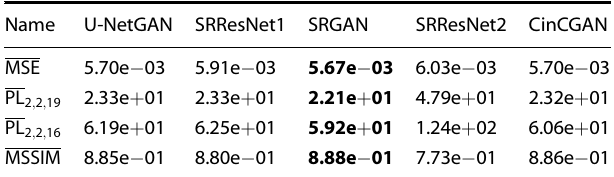
Table 2. Quantitative comparison of super-resolution results, where the values of MSE , PL 2 ; 2 ; 16 , PL 2 ; 2 ; 19 , and MSSIM obtained for SRGAN (marked in boldface) indicate that SRGAN leads to better predictions than the remaining four